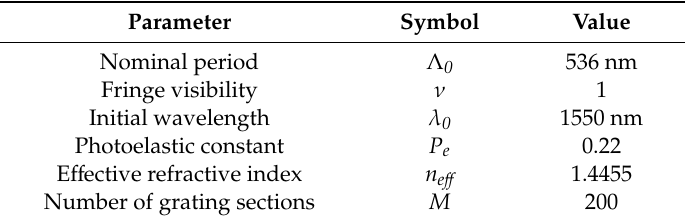
Table 1. Parameters employed in the gratings